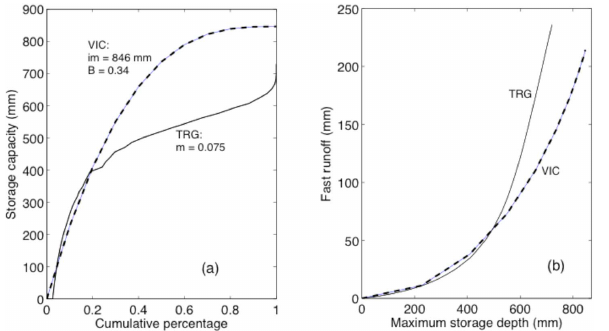
Fig. 11. (a) Basin average storage distribution for Dongjiang river basin by the TRG method, and the fitted VIC model curve. (b) Basin average relationship between the maximum storage depth and fast runoff in the Dongjiang river basin.